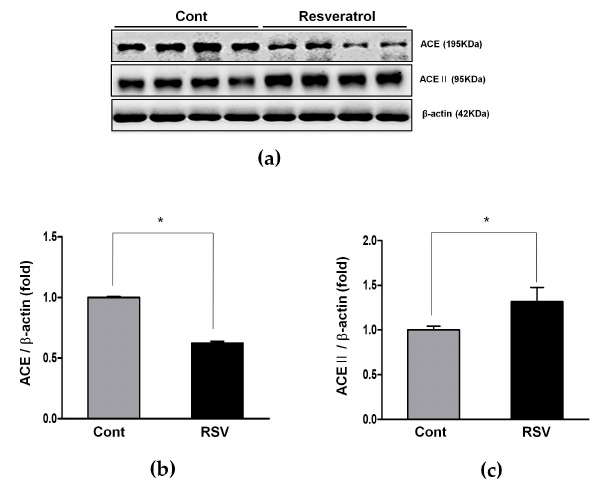
Figure 4. Effects of resveratrol on the angiotensin converting enzyme (ACE) and ACEII protein expressions. ( a ) Representative western blots of ACE and ACEII protein levels. ( b ) The protein levels of ACE were lower in the RSV group than in the control (Cont.) group. ( c ) The protein levels of ACEII were higher in the RSV group than in the control group. Quantitative analysis of the results is shown (* p < 0.05).